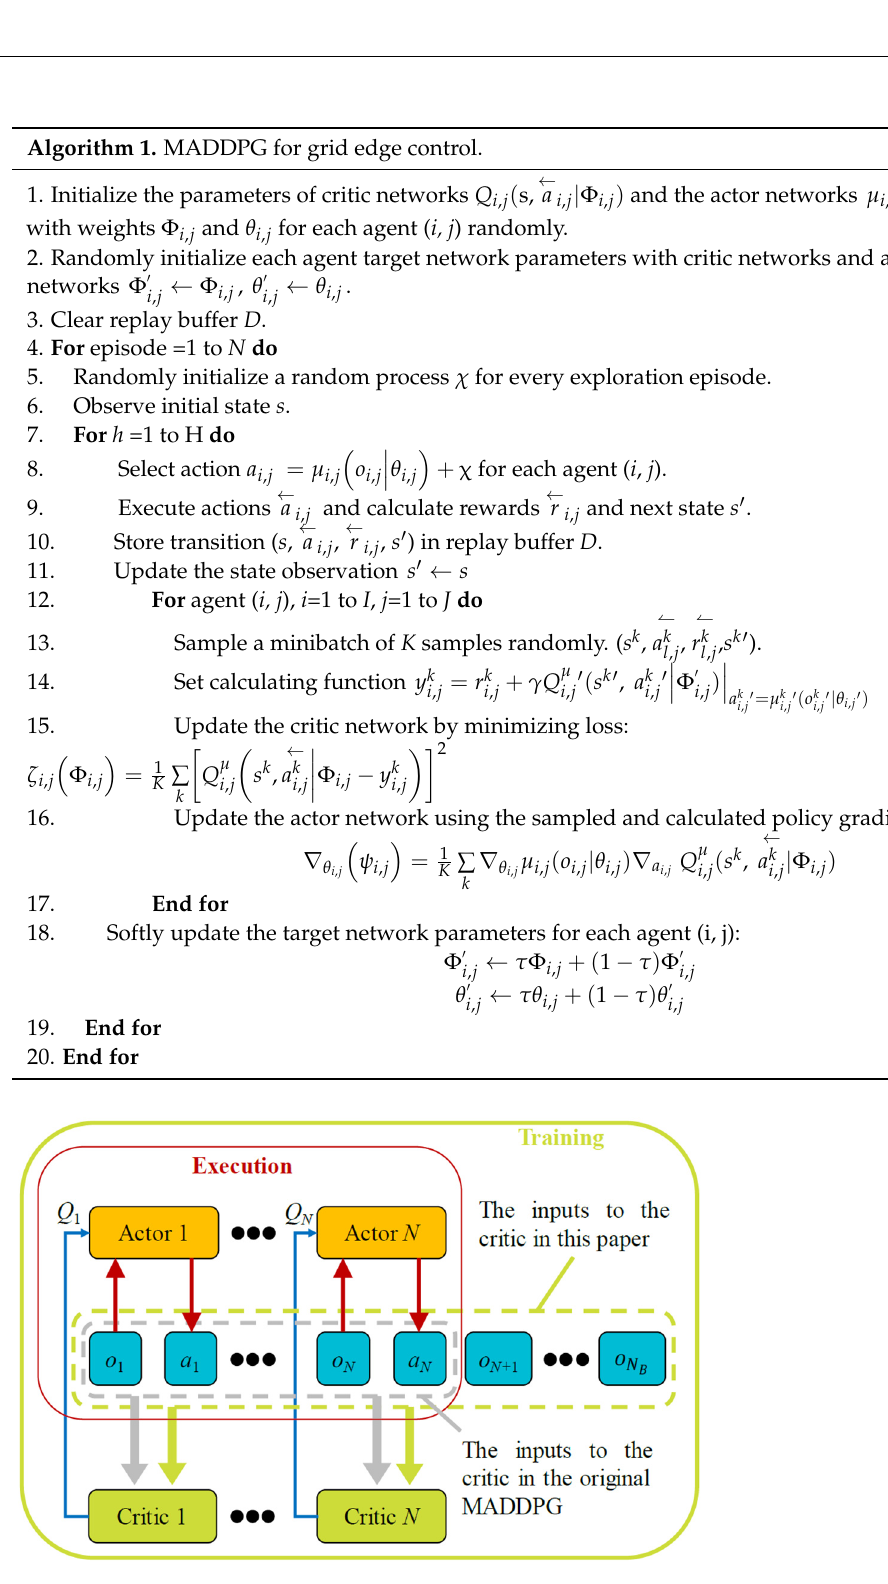
Figure 6. Structure of training with the MADDPG algorithm. Algorithm 1: MADDPG for grid edge control.